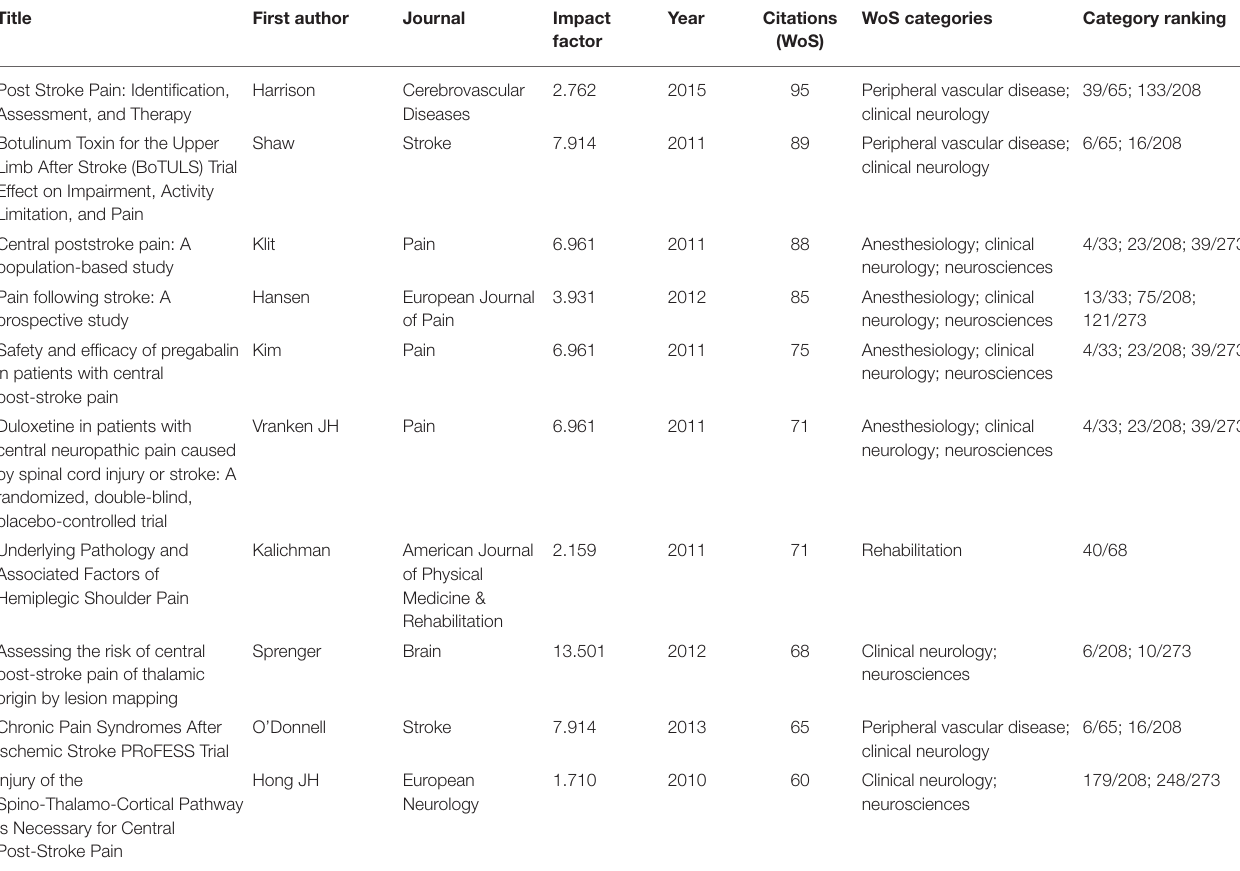
TABLE 4 | The top 10 articles with the most citation frequency in pain after